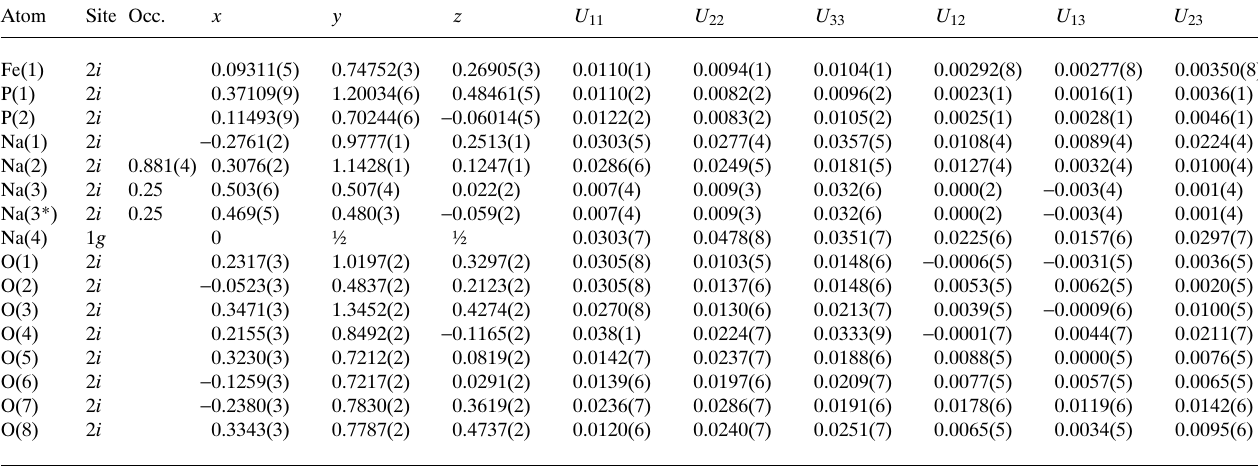
Table 2. Atomic coordinates and displacement parameters (in Å 2 ) . Atom Site Occ.